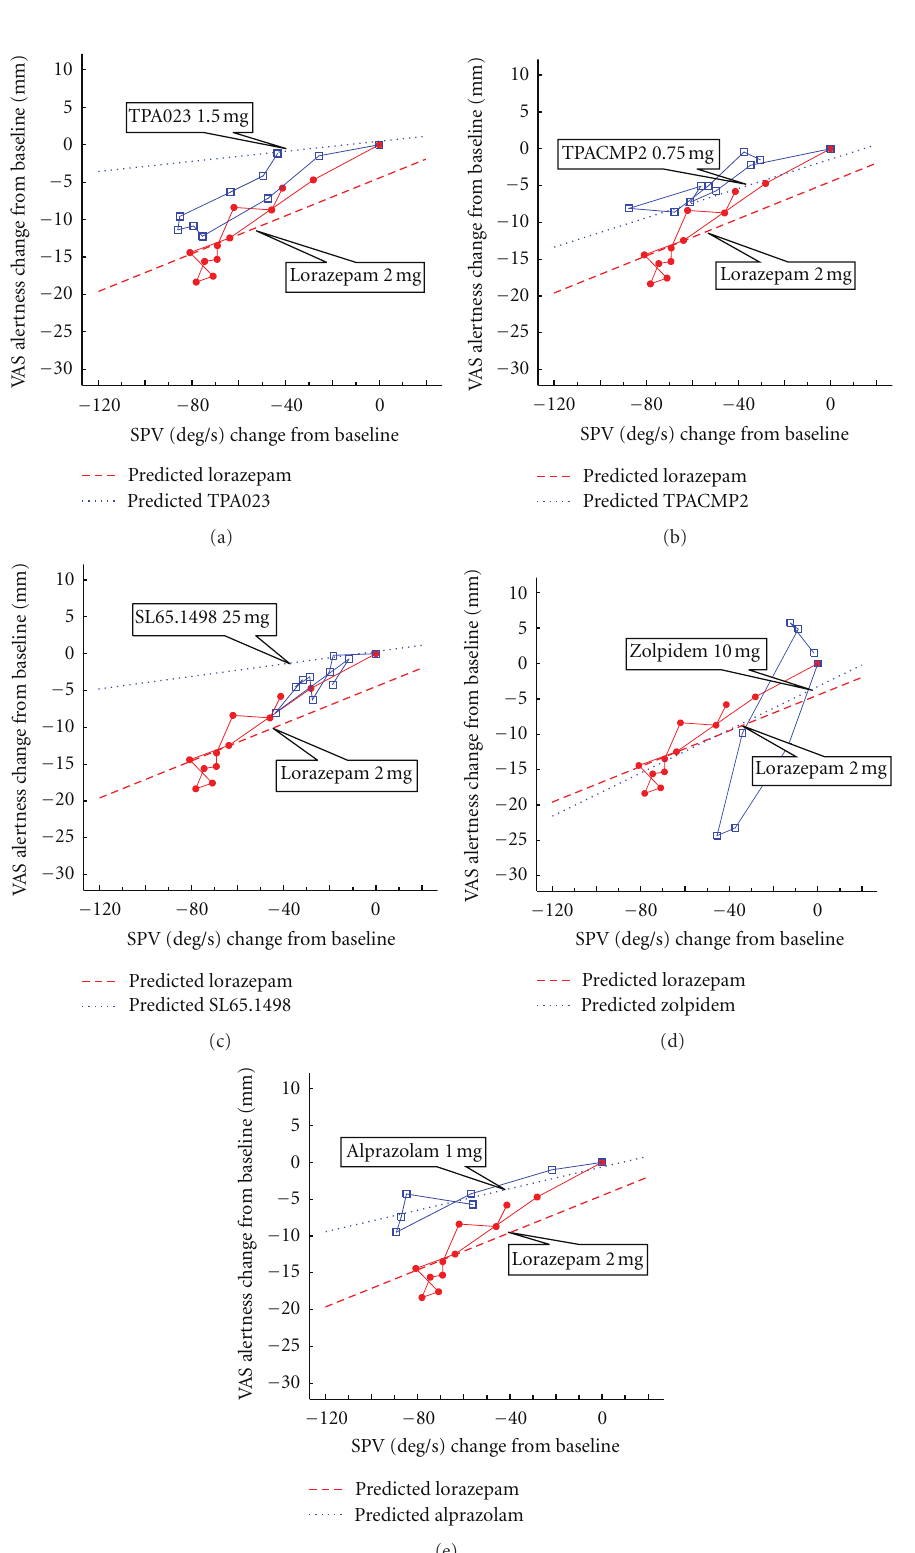
Figure 2: Δ VAS alertness - Δ SPV relative e ff ect profile of TPA023 1.5 mg, TPACMP2 0.75 mg, SL65.1498 25 mg, zolpidem 10 mg, and alprazolam 1mg versus lorazepam 2mg, respectively. (Blue open square: investigational compound; red closed circle: lorazepam 2 mg; blue dot line: the comparator drug, red dash line; lorazepam